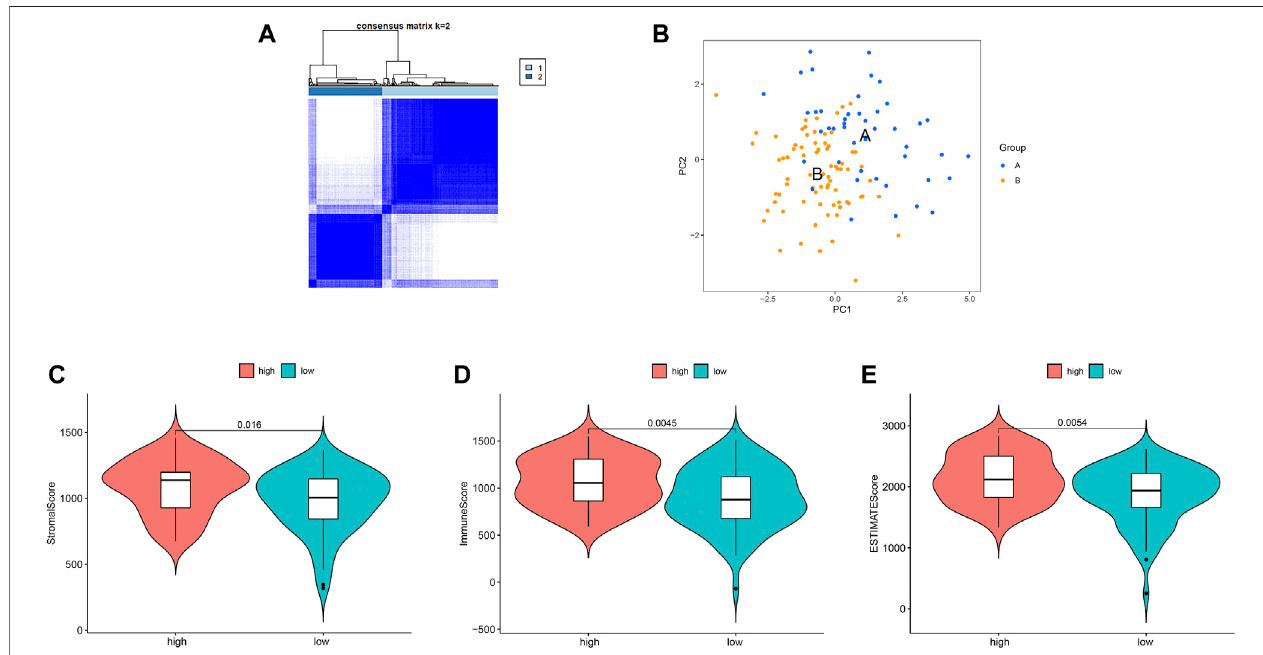
FIGURE7| Ferroptosisclustersandcorrelationswiththetumormicroenvironment. (A) Resultsobtainedfromconsensusclusteringidenti fi edtwodifferentclusters, namely cluster 1, and 2. (B) Two-dimensional plots of two groups with the top two principal components, in which blue dots represented group A, and orange dots represented group B. (C) Patients in high-ferroptosis had higher stromal score, immune score and ESTIMATE score, as shown in (C – E) respectively.